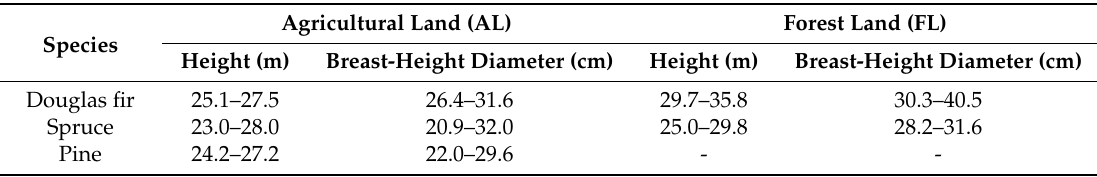
Table 1. Height and diameter of the sample